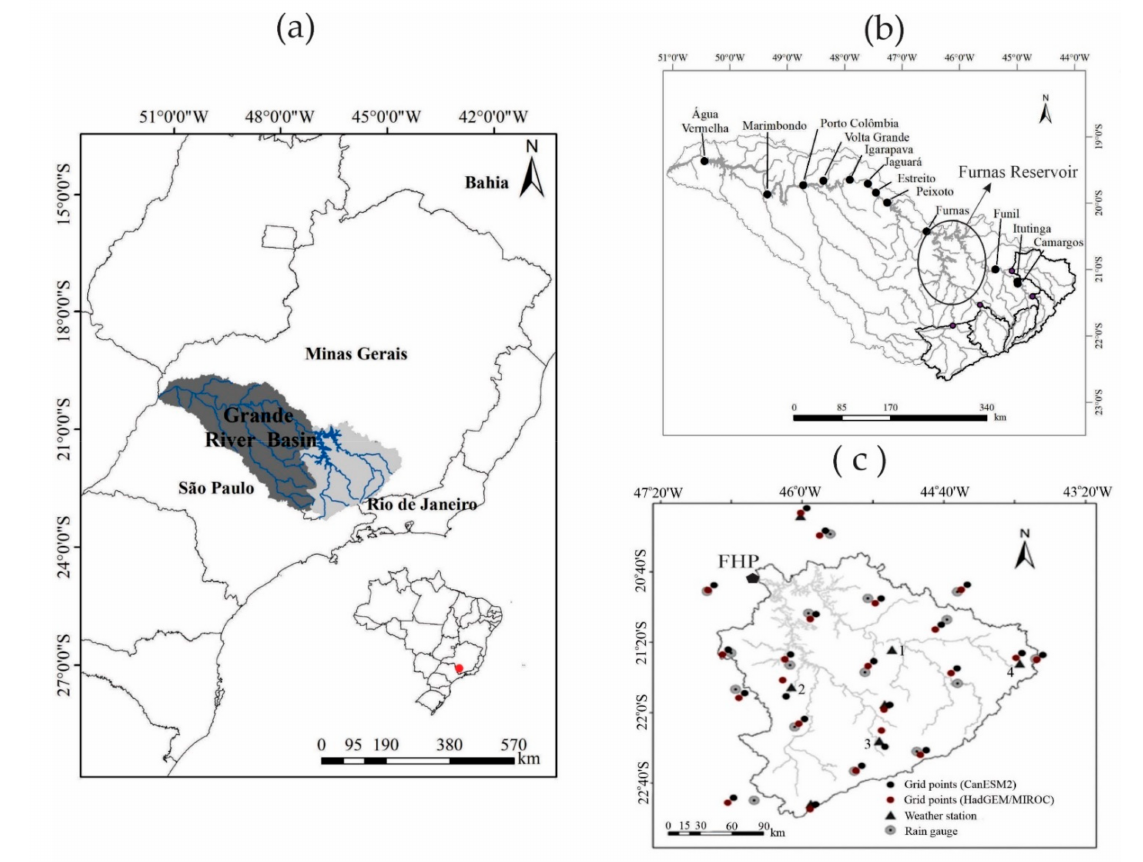
Figure 1. ( a ) The geographical location of the Grande River Basin (GRB)-Furnas; ( b ) Grande river basin with the cascade of hydropower plants and the main headwater sub-basins; ( c ) the GRB-Furnas basin, rain gauges, weather stations, and grid points of the regional climate models (RCMs) used in this